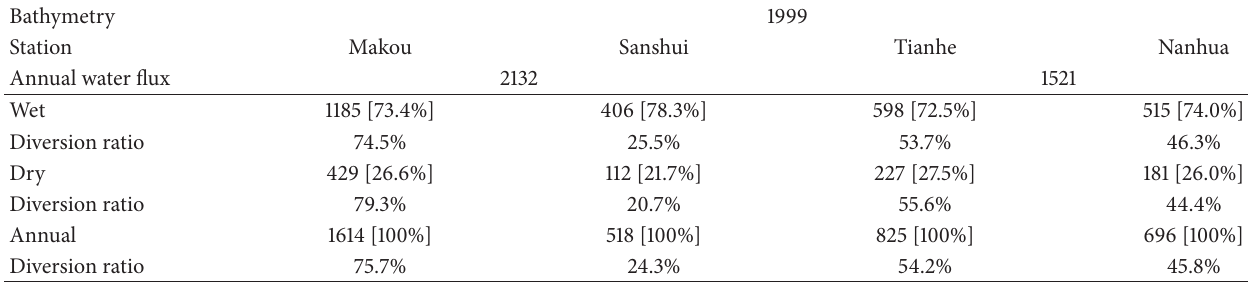
Table 2: The water flux and the diversion ratio at the two main joints in the Pearl River network: (a) Makou and Sanshui and (b) Tianhe and Nanhua (unit: × 10 8 m 3 ).